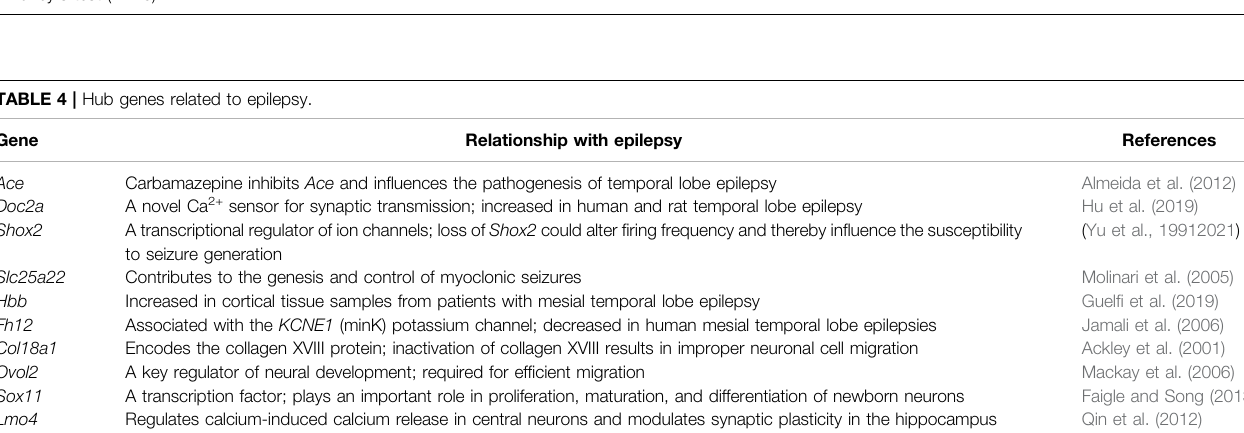
FIGURE 6 | The protein levels of ACE in the hippocampus of rats were determined by Western blot analysis. (A) Representative Western blot bands of ACE. (B) Quantitative analysis of ACE. β -Tubulin was used as the internal control. * p < 0.05. Data are expressed as mean ± SD and analyzed using one-way ANOVA followed by Tukey ’ s test ( n = 3).